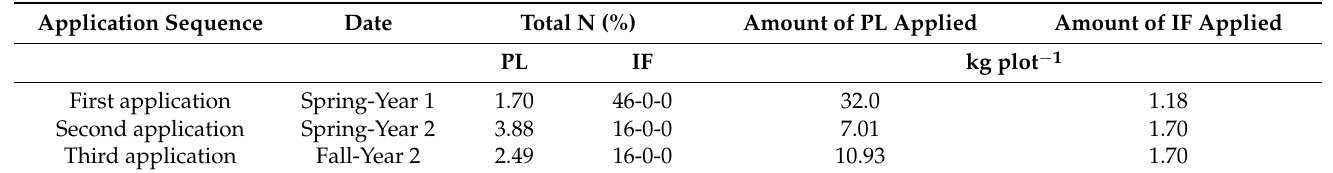
Table 2. Poultry litter (PL) and inorganic fertilizer (IF) rates and sequence of applications.